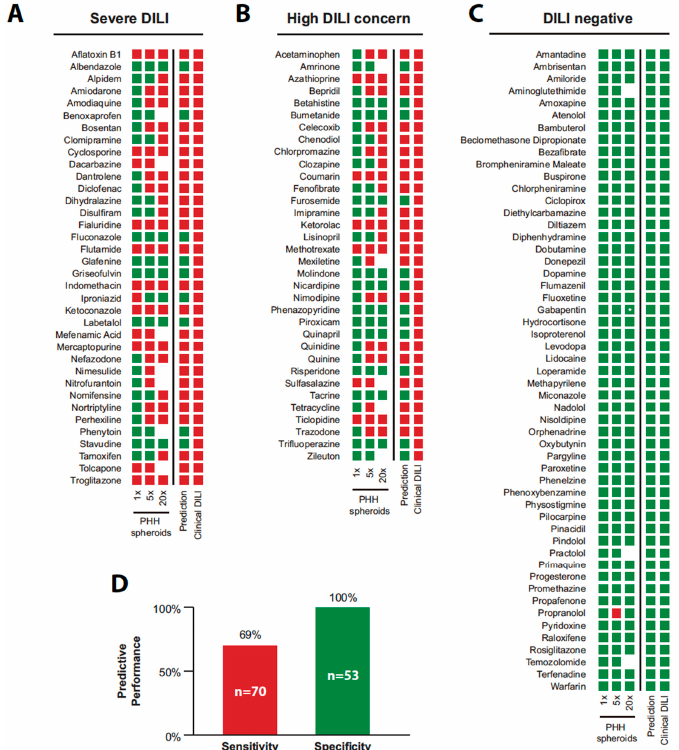
Figure 2. Compounds with potential hepatotoxicity indicated by chemically defined-spheroid model. Results of drug-induced liver injury (DILI) evaluation are shown for those with acute DILI ( n = 36; ( A )), with potential DILI ( n = 34; ( B )), and DILI-negative ( n = 53; ( C )). Red boxes show the average hepatocyte viability to be significantly decreased ( < 80% of the control, p < 0.05). The rating is classified as negative (green) when these conditions are not met. ( D ) The spheroid model indicated 69% of DILI-positive drugs as hepatotoxic with no false positives. Reprinted from reference